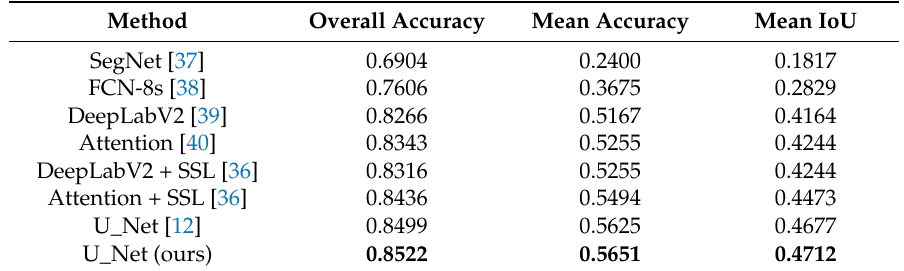
Table 2. Performance of human semantic segmentation on the validation split of LIP.